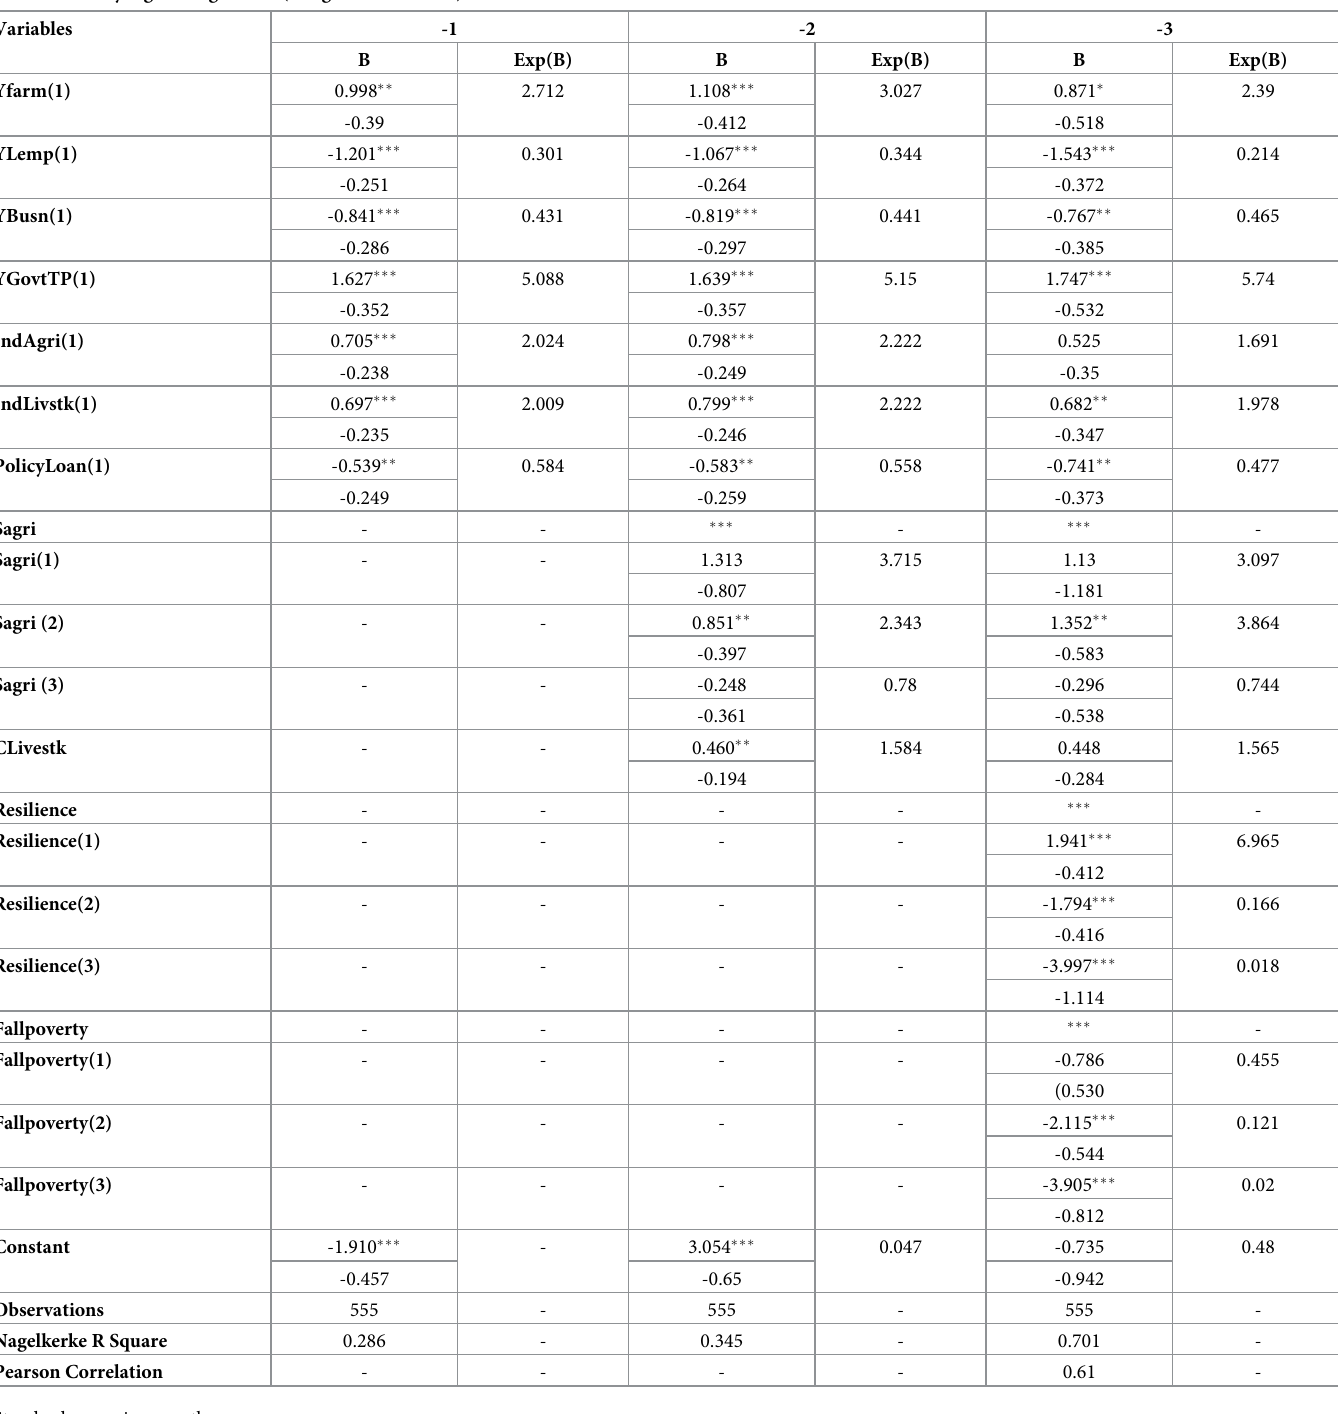
Table 8. Binary logistic regression (categorical